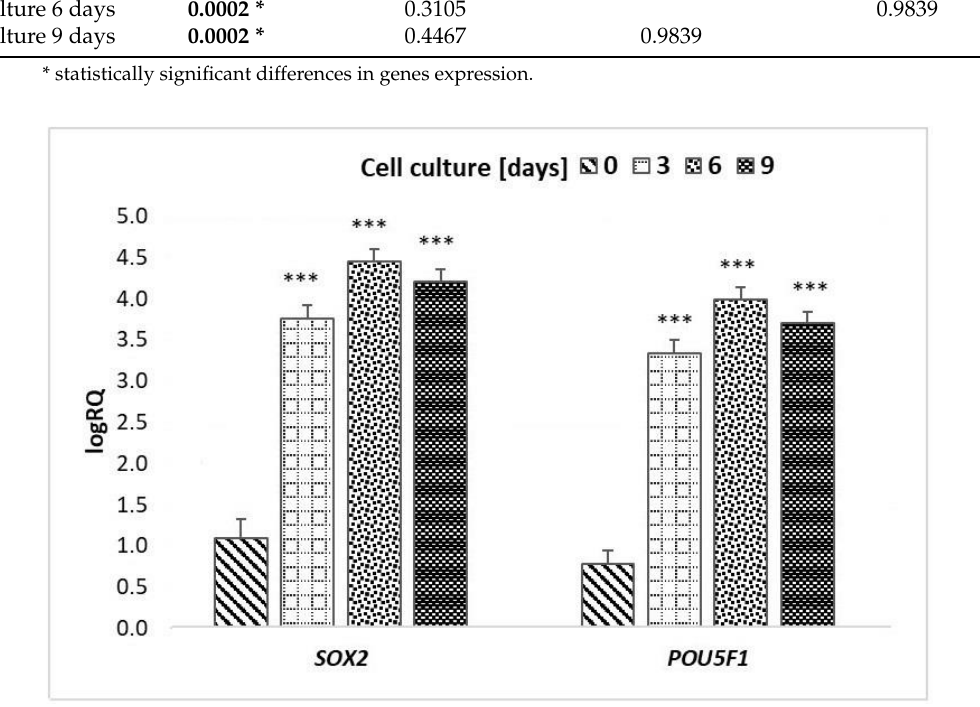
Figure 3. Mean and standard deviation values of LogRQ for the SOX2 gene and POU5F1 gene in peripheral blood stem cells prior to culture (day “ 0 ” ) and on subsequent days of culture (3, 6 and 9 days). Explains: *** p < 0.001.